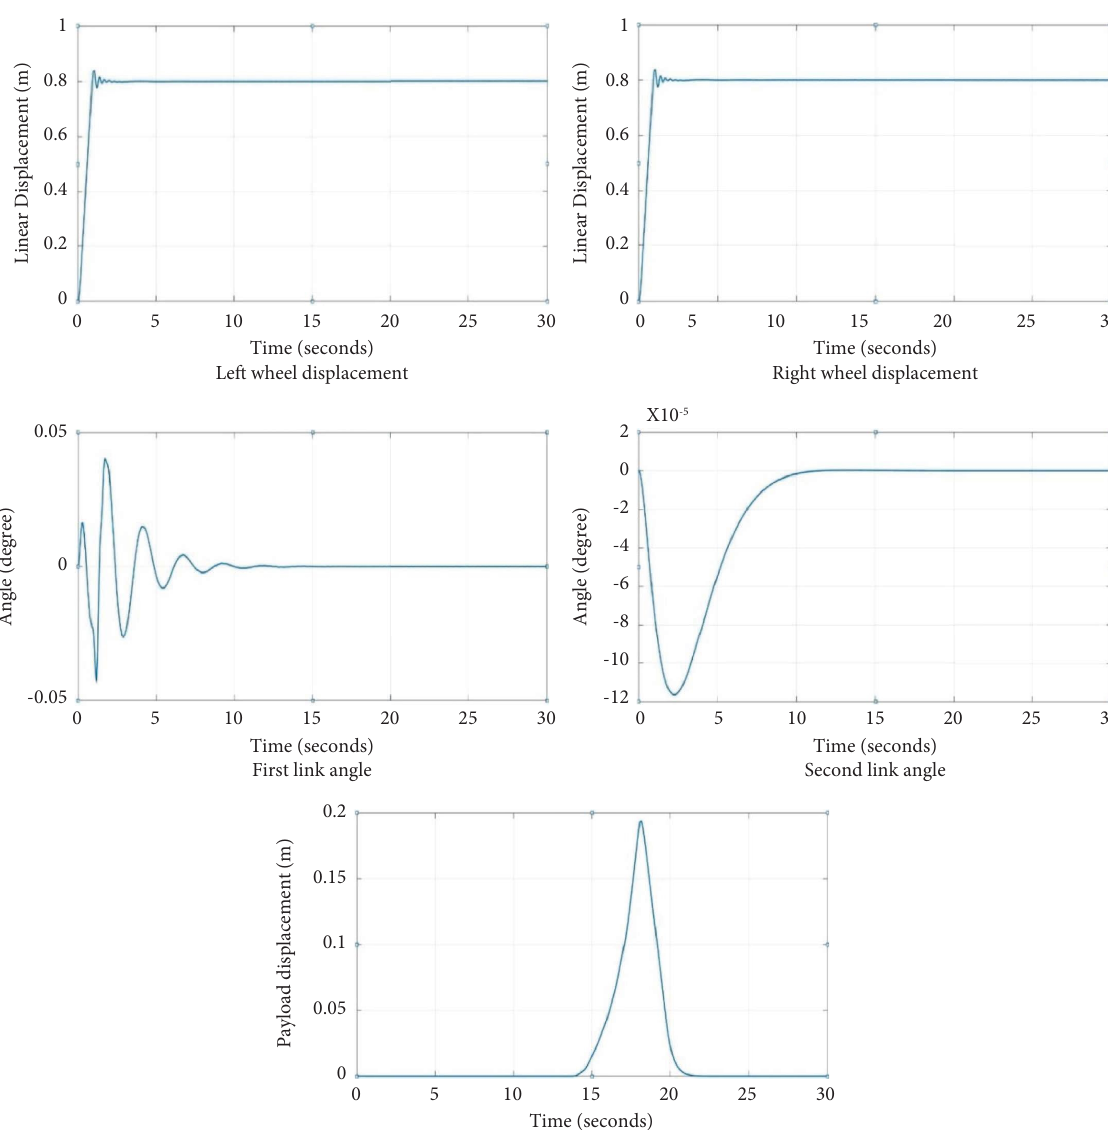
Figure 11: System response with the third input signal using hybrid